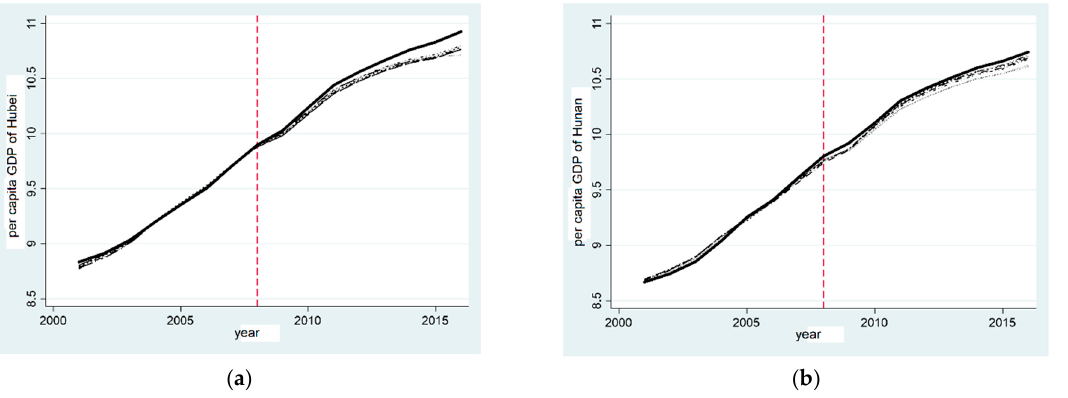
Figure 8. Sensitivity analysis of average GDP of provinces in the “two-oriented society” pilot zone. ( a ) Hubei; ( b ) Hunan.